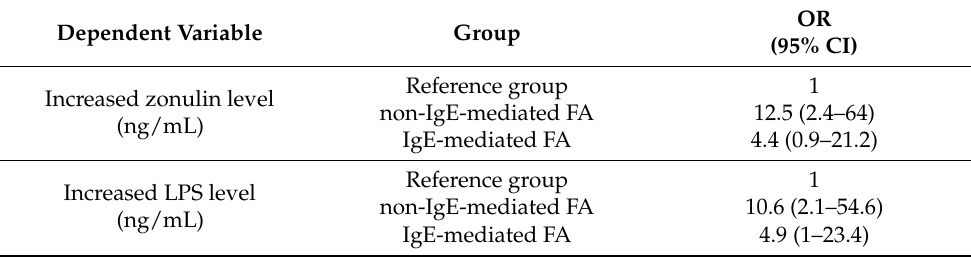
Table 5. Risk factors for increased zonulin level (>2 tertiles 41 ng/mL) and increased LPS level (>2 tertiles 1071 ng/mL) in the analysed groups of children with IgE-mediated and non-IgE-mediated food